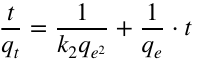
Fig. 8 Pseudo-second-order kinetics of HAp on arsenic of 0.3 mg/L at 120 rpm, temperature 30 °C and pH of